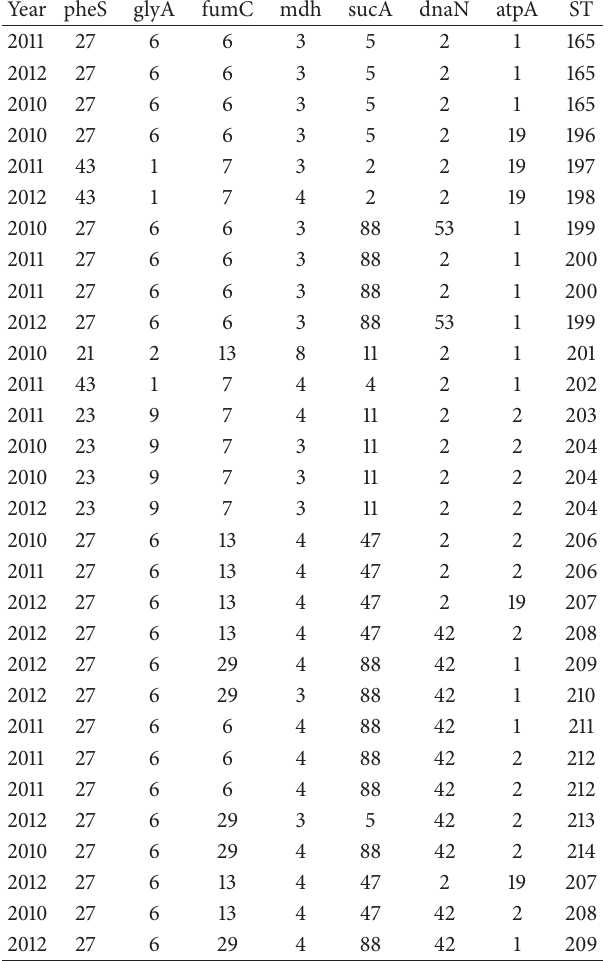
Table 2: The allele variants from each gene and the sequence types (ST) of A. phagocytophilum strains originating from Norwegian Ixodes ricinus ticks. The allele variants were identified by the nonredundant database, and STs were assigned.